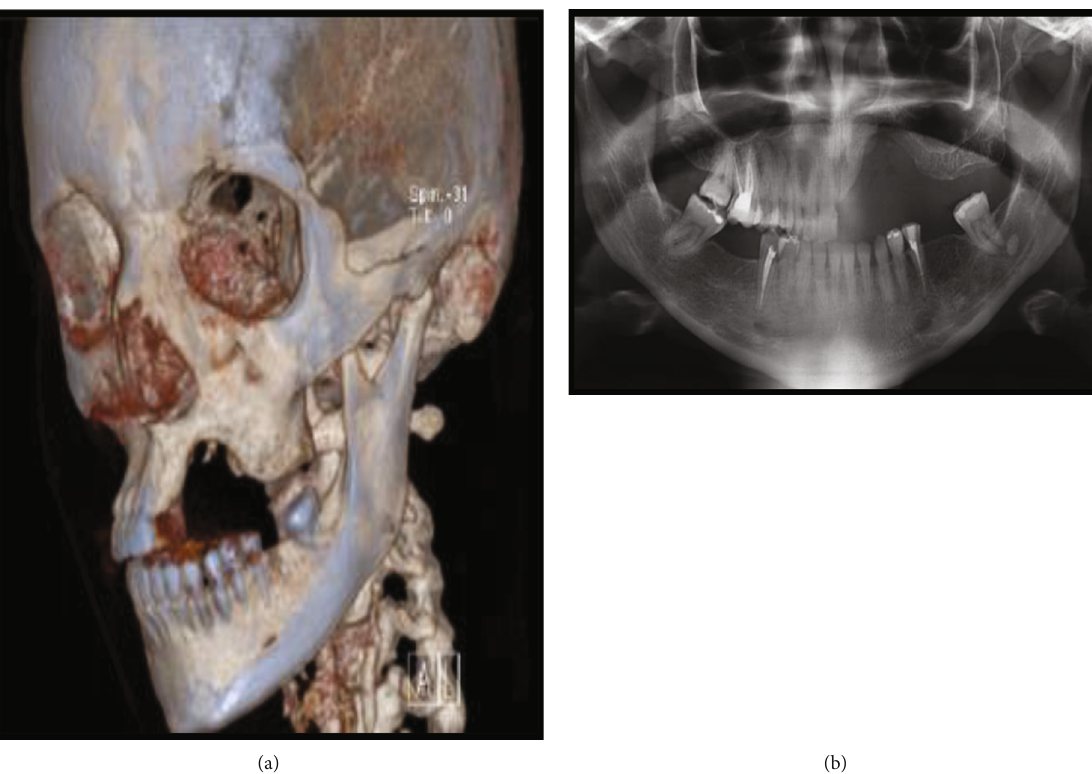
Figure 1: (a) Three-dimensional computed tomography showing partial bony defect of the left maxillary bone. (b) Preoperative panoramic radiography showing a large radiolucent area at the left side of the